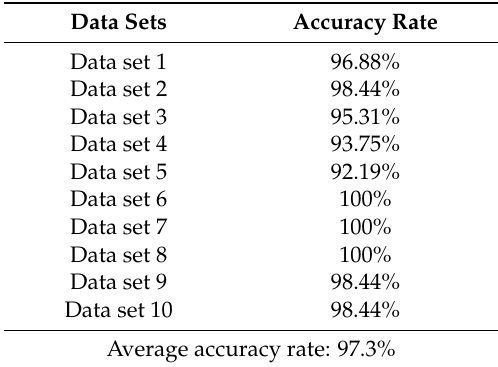
Table 2. Results of fabric pilling grade obtained using proposed T2FCMAC classifier.